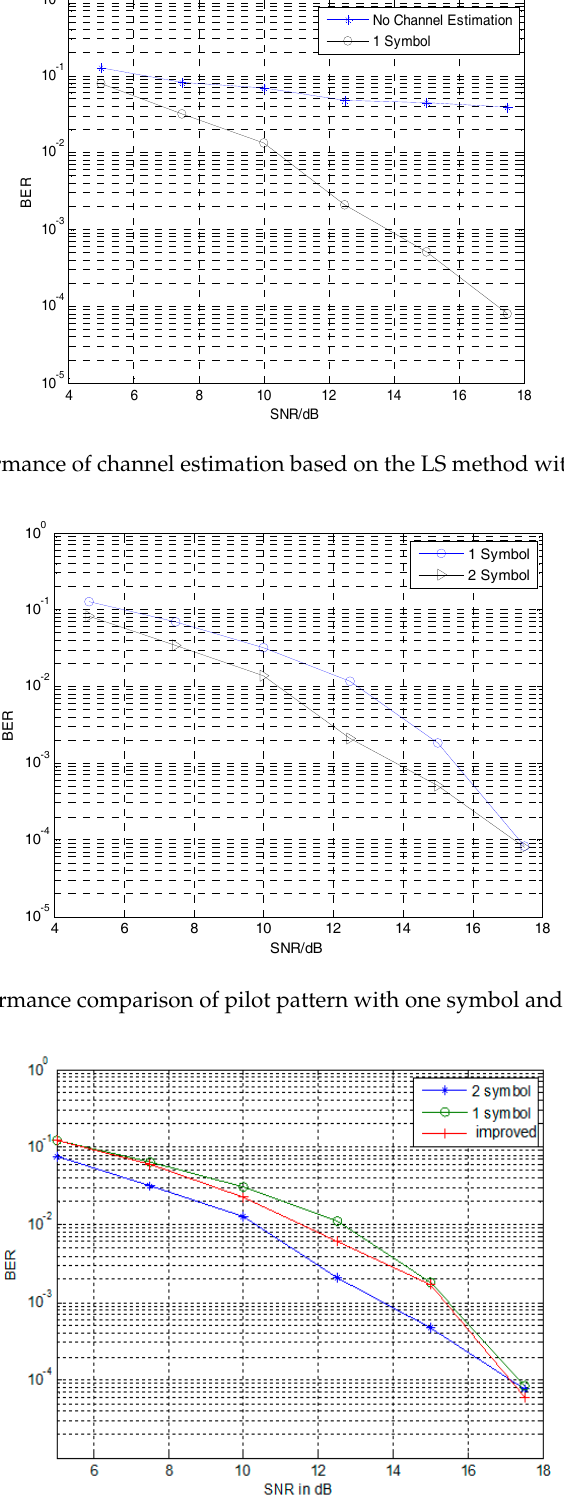
Figure 6. Performance of channel estimation using a double-symbol pilot pattern.